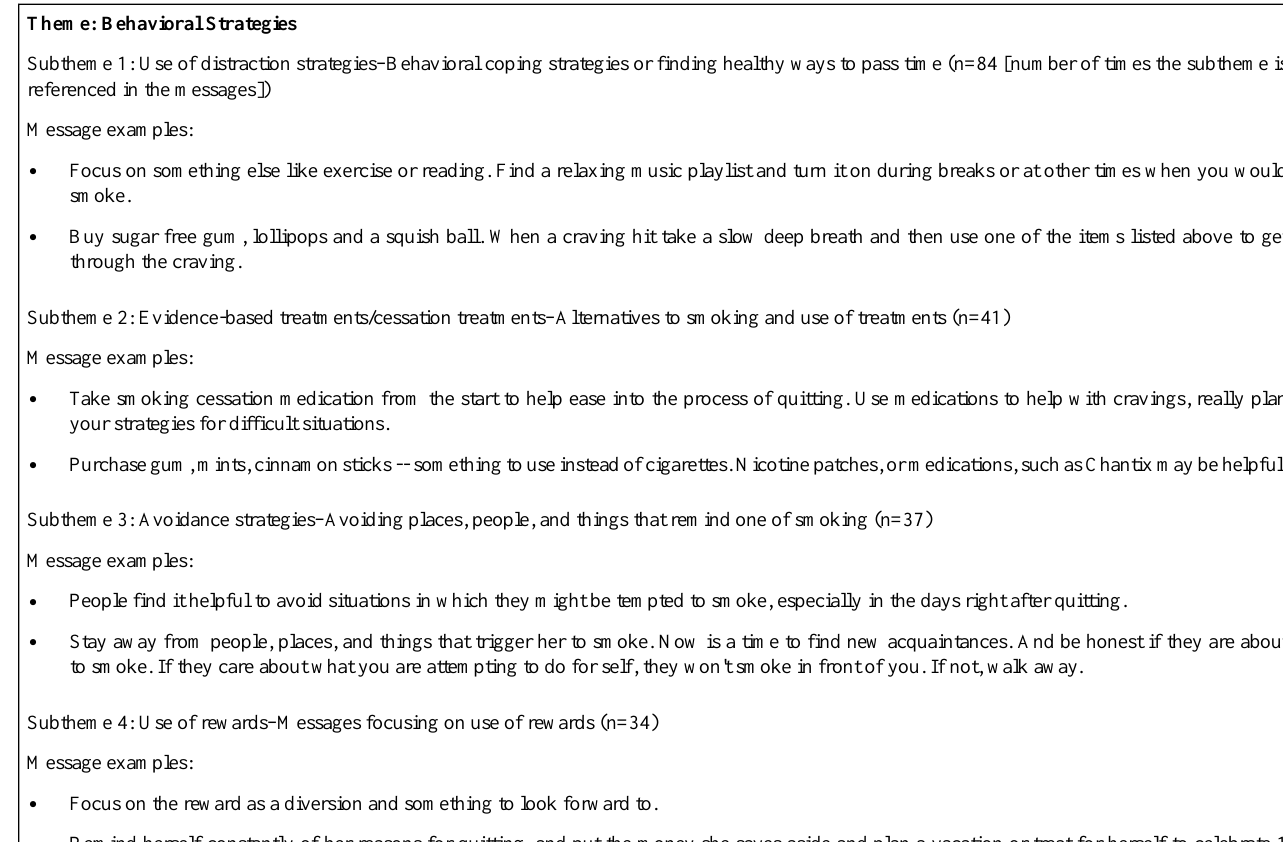
Textbox 1. Themes of behavioral strategies and seeking help, and their subthemes derived from messages (N=318) written by African American smokers who participated in our online